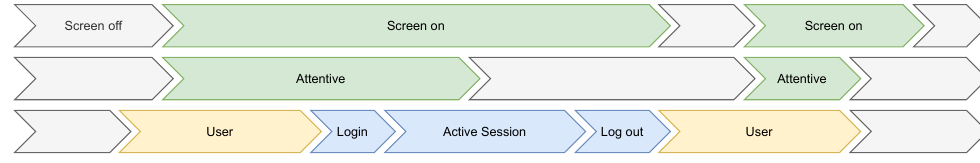
Figure 16. Active Session flow